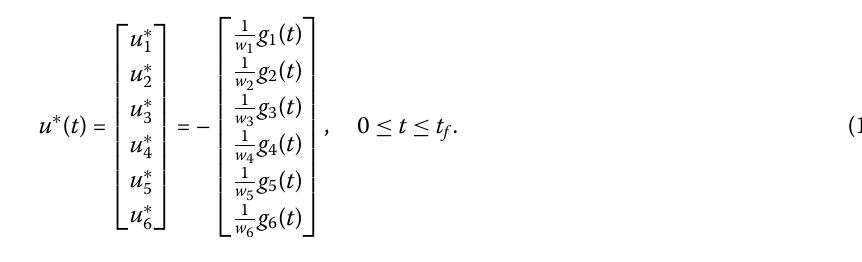
the boundary conditions (14). Also, the optimal control is computed by